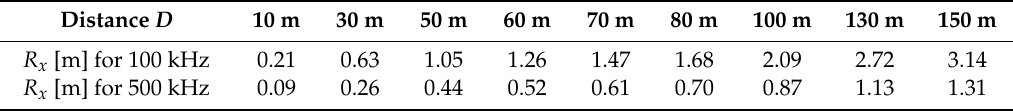
Table 3. Calculated along-track resolution of the DF-1000 EdgeTech side-scan sonar. Distance D 10